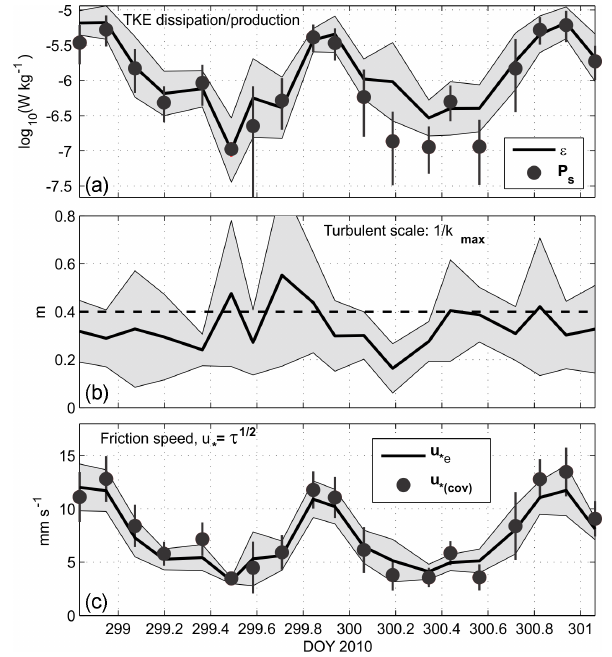
Figure 5. (a) Three-hour averages of turbulent kinetic energy dissi- pation rate (solid with shading showing ± 1 standard deviation of the 15min realizations in each average) and TKE production by shear (circles with standard deviation). (b) Turbulent length scale from the inverse wavenumber at w variance spectral peaks. Dashed line indicates the “geometric” surface layer scale, κ | z | . (c) Independent estimates of friction speed from w variance spectra (solid with shad- ing) and from covariance statistics (circles with standard deviation bars).